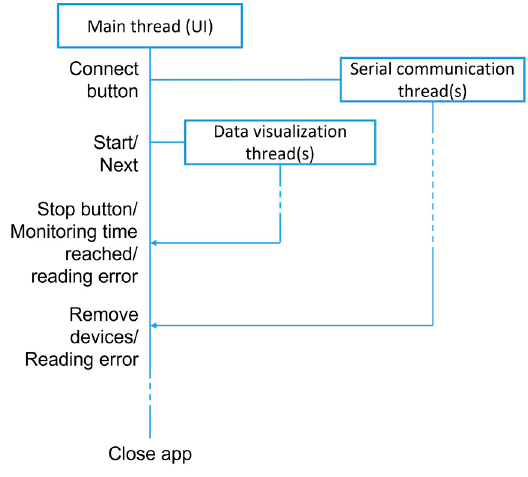
Figure 5. General code structure developed using multithreading.